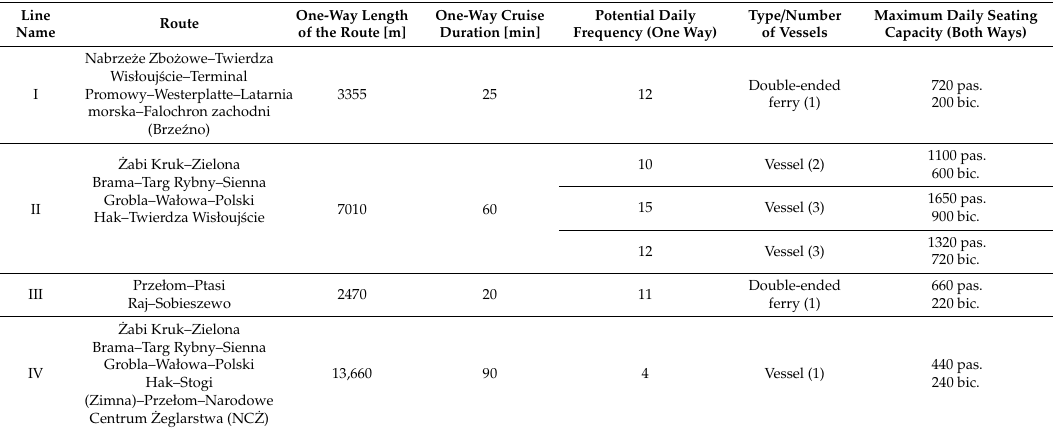
Table 3. Characteristics of the proposed water tram lines in